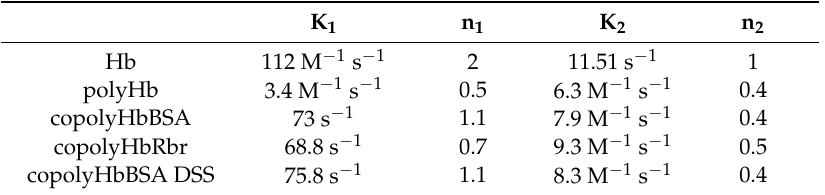
Table 2. Rate constants and reaction order calculated for different candidates such as blood substitutes for the oxyHb + nitrite reaction. Conditions: 66 µM protein, various concentrations of nitrite, PBS 7.4, room temperature.